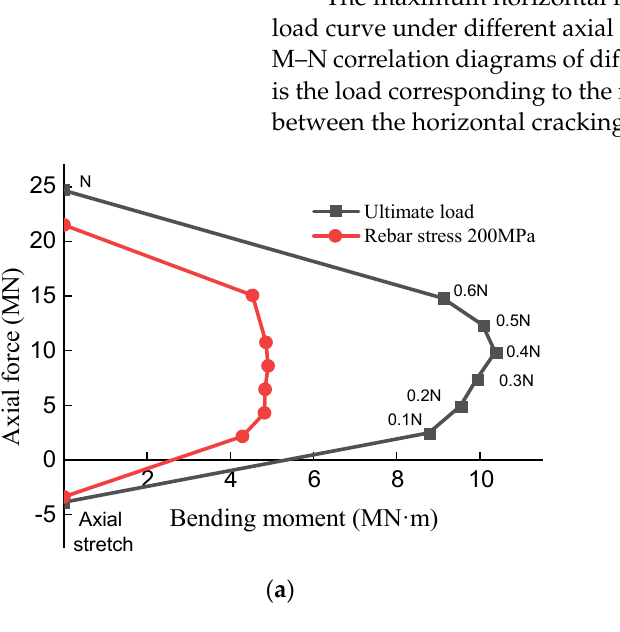
Vertical displacement (mm) Cast-in-place components Prefabricated components Figure 22. Displacement–load comparison diagram of full-scale socket connection. 5.2. Bending Moment and Axial Force Correlation Analysis To further study the factors affecting the mechanical properties of the full-scale model, parameter analysis of axial compression was performed. In practical engineering applications, the pile part of the cushion cap needs to be inserted deep into the ground to ensure the stability of this component, and the pile length is larger than the full-scale model mentioned above. To make the model closer to the actual project, a full-scale model with a pile length of 5 m was added. First, the model was subjected to vertical displacement loading to obtain the maximum vertical load N of the model, and then horizontal displacement loading was applied to the components with 0.1, 0.2, 0.3, 0.4, and